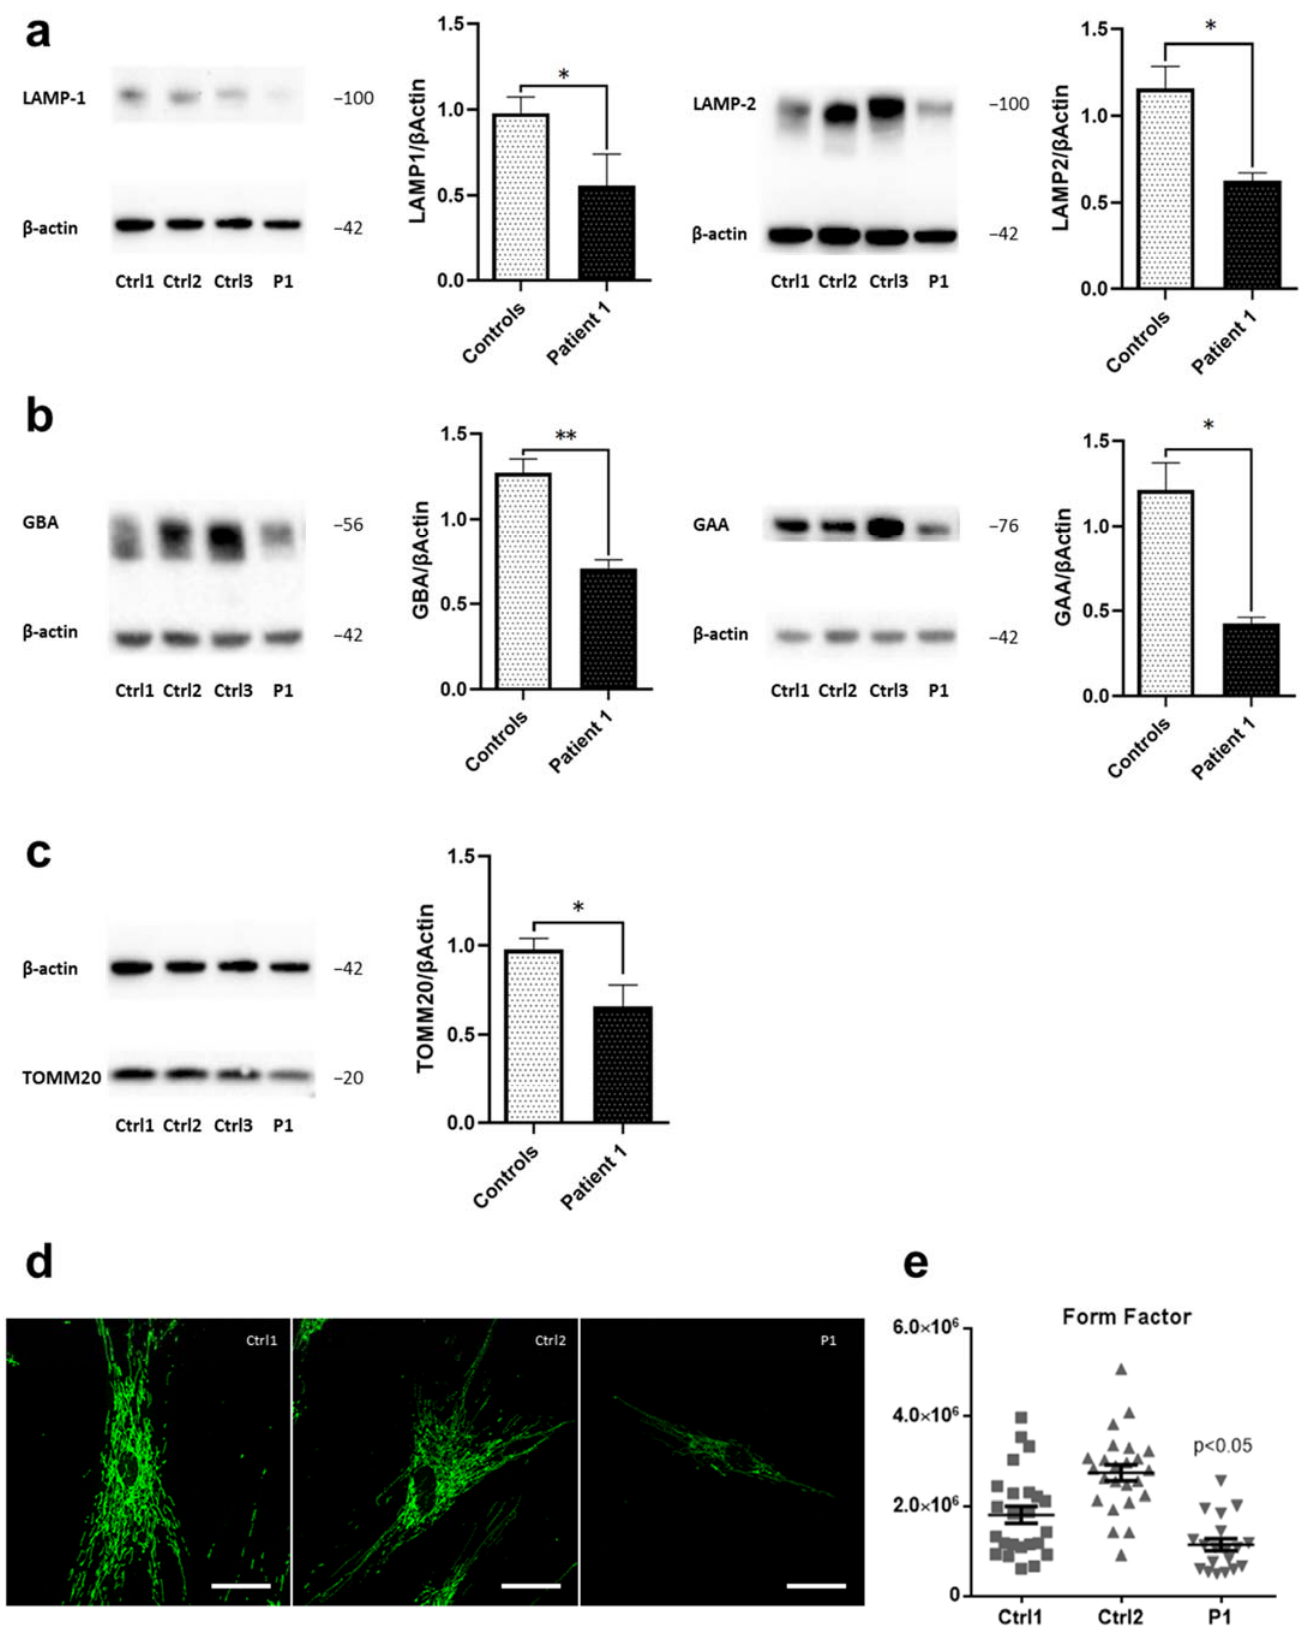
Figure 2. Disrupted lysosomal and mitochondrial integrity in WDR45 -mutant fibroblasts. Western blot analysis of total protein extract from: ( a ) fibroblasts from WDR45 mutation